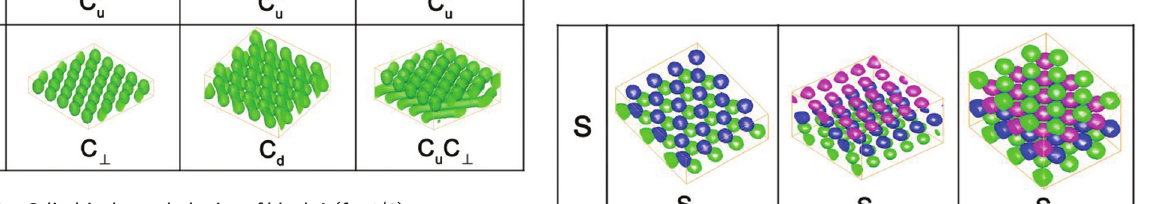
Figure 2: Cylindrical morphologies of block A ( f